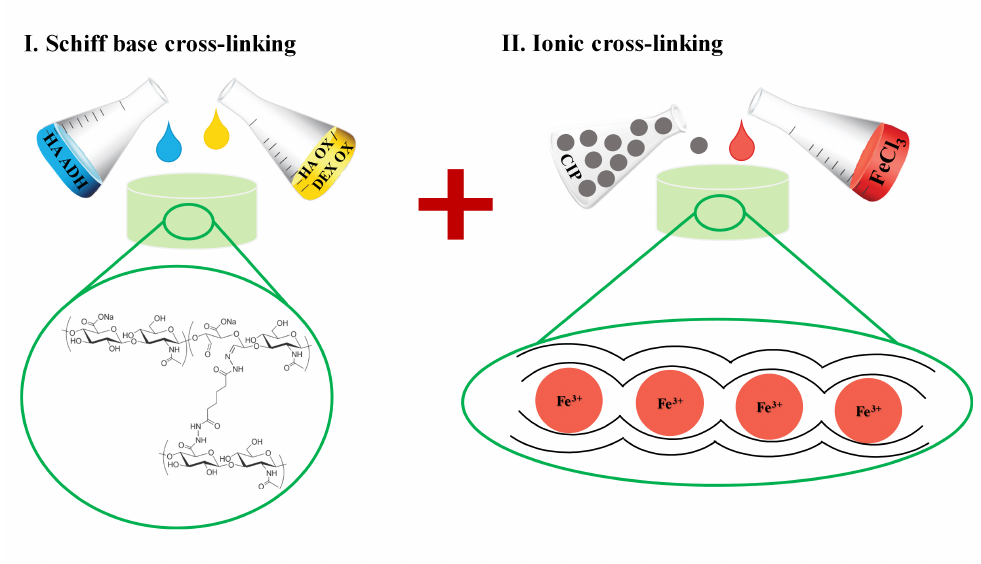
Figure 5. Schematic representation of ( I ) Schiff base cross-linking and ( II ) subsequent ionic cross- linking of prepared hydrogels with optional incorporation of magnetoresponsive filler